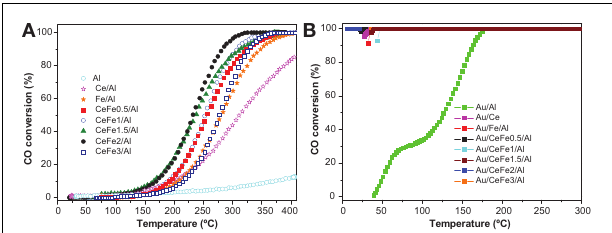
FIGURE 7 | CO oxidation light-off curves of the (A) supports; (B) gold catalysts.